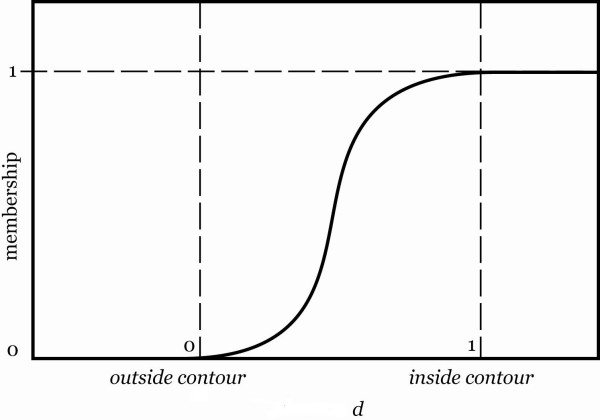
the membership function μlocation based on pixel position. In this Figure  and dinsideand doutside are the shortest euclidian distance to the outside and inside contours respectively.